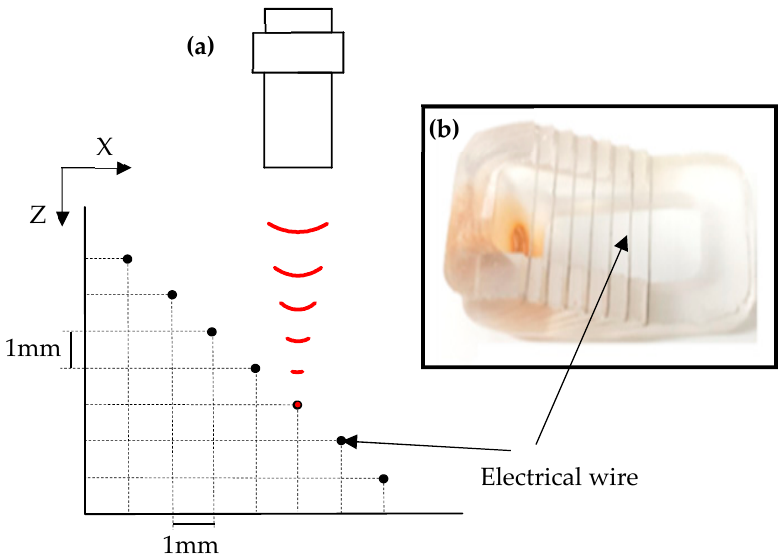
Figure 7. ( a ) The schematic of wire phantom test. ( b ) The photograph of wire phantom.